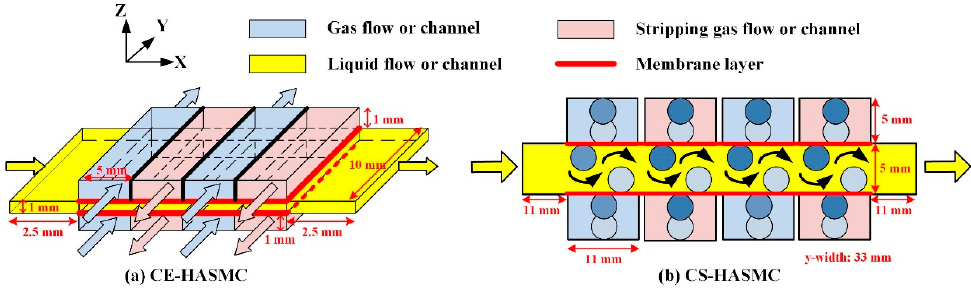
Figure 2. Cross-flow HASMCs with ( a ) empty channels or ( b ) spacer-filled channels.